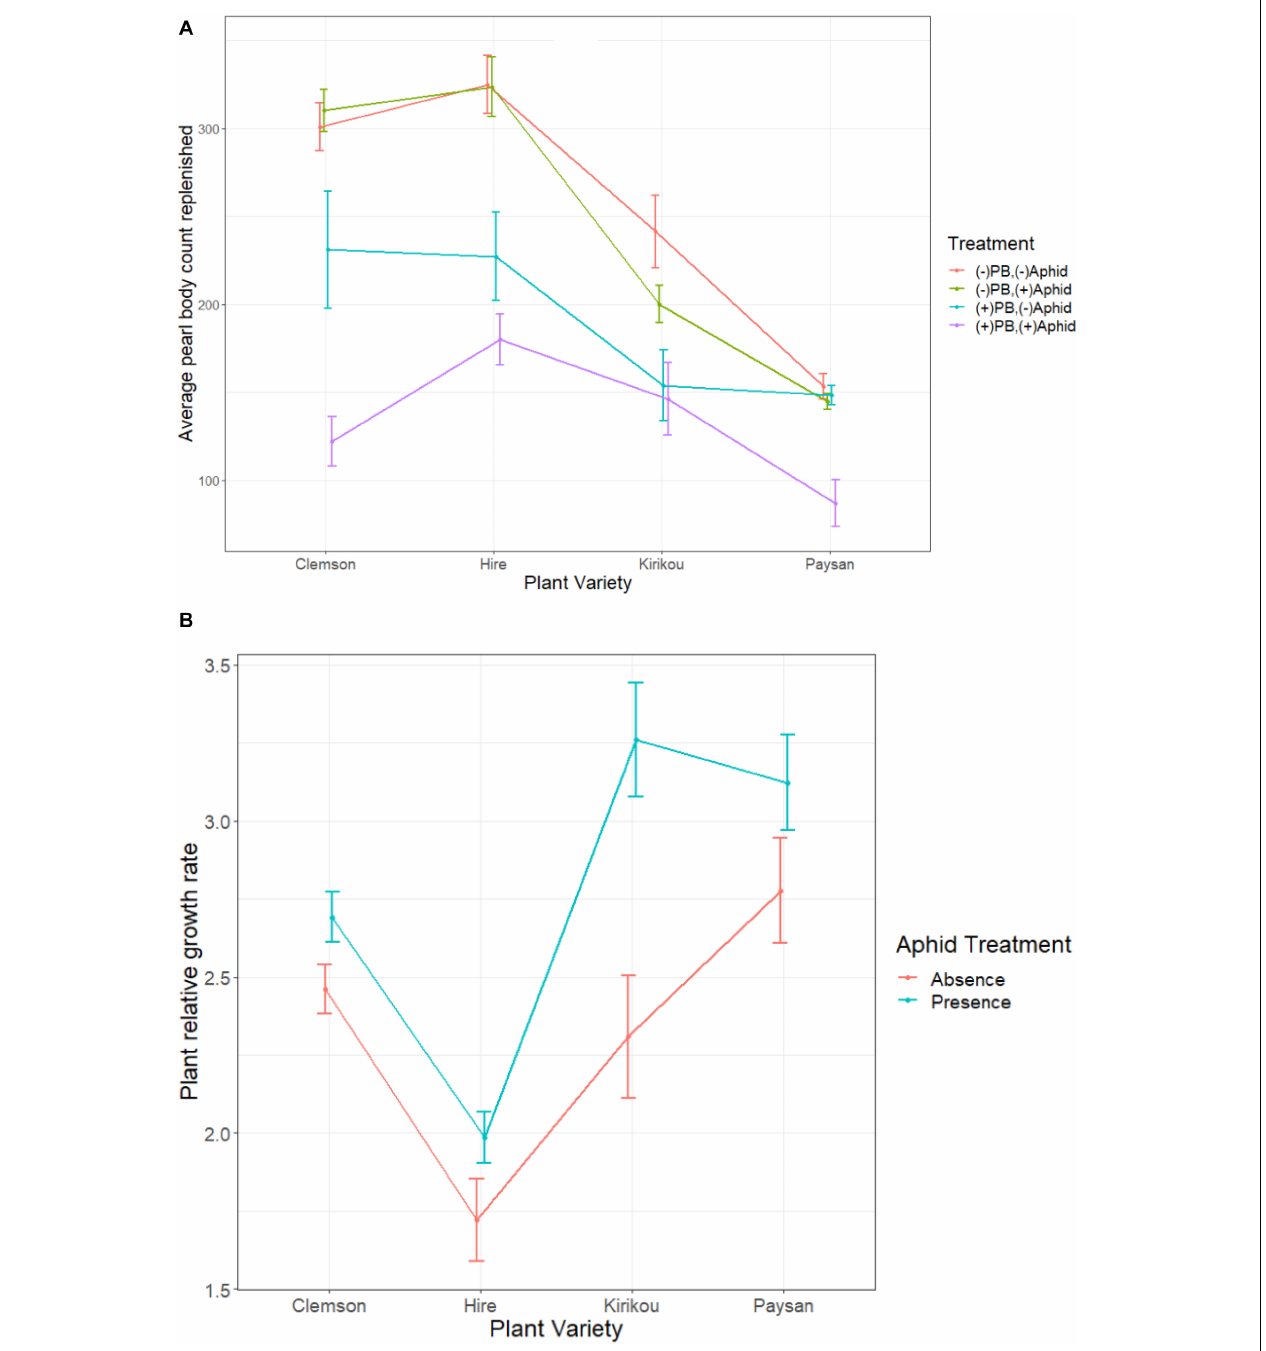
FIGURE 3 | (A) Effect of aphid presence and absence on count of replenished pearl bodies, across different okra varieties in different pearl body treatments (PB Kept and PB removed). Pearl bodies were artificially removed at the beginning of the experiment only in PB removed plants. (B) Effect of aphid presence and absence on plant relative growth rate across different okra varieties. Error bars represent ± 1 SE.